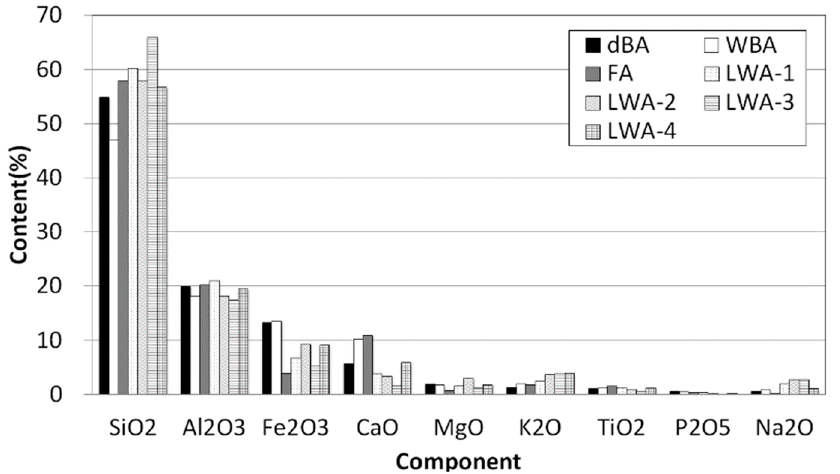
Figure 8. Major oxide composition of the test